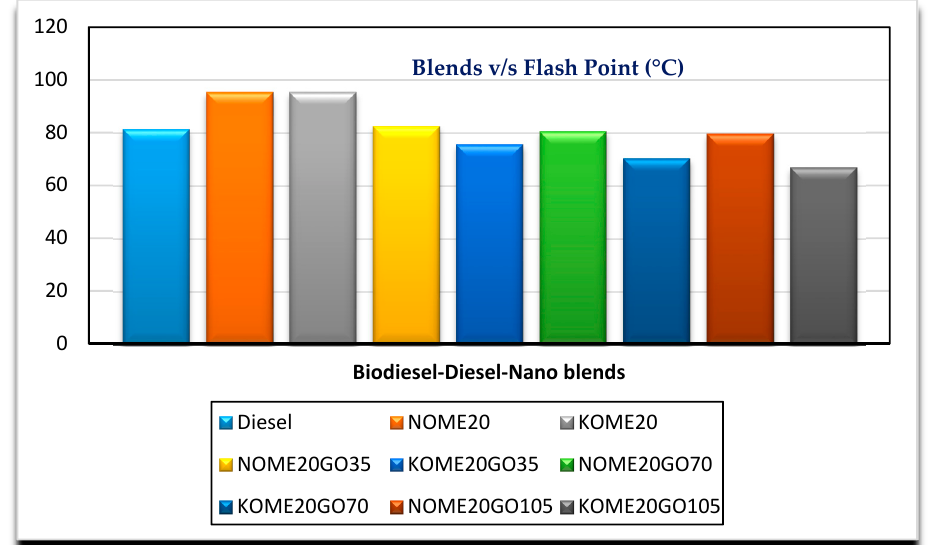
Figure 9. Variation of flash point with Biodiesel-Diesel-Nano blends. Table 7. Fuel properties of Karanja Biodiesel-Diesel-Nano blends by DT method.